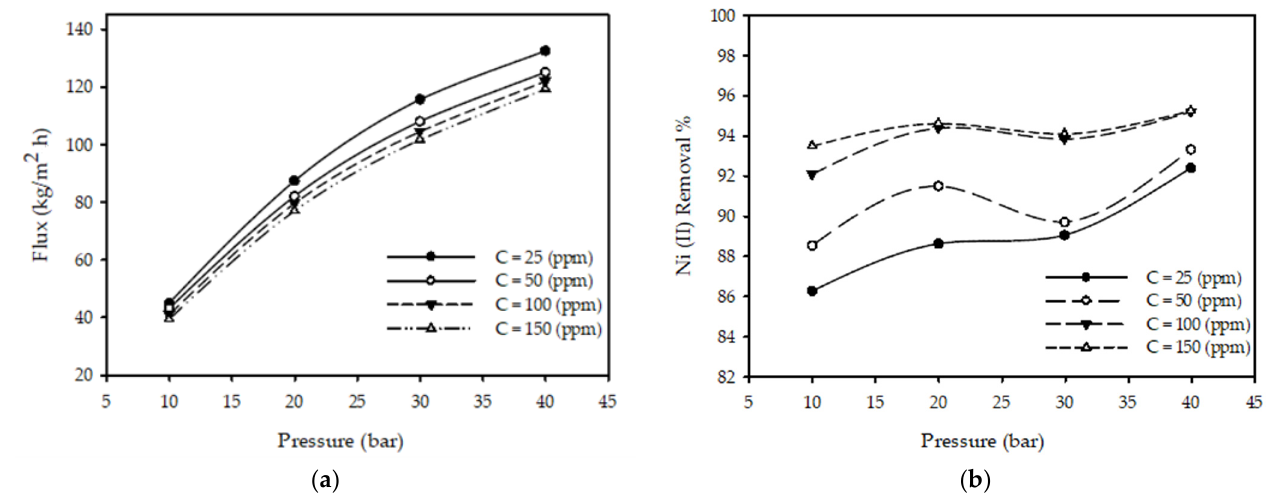
Figure 3. Effect of pressure on ( a ) permeate flux and ( b ) Ni (II) removal % under alternating feed concentrations with a fixed inlet feed flow rate of 3.2 L/min and a feed temperature of 25 °C.